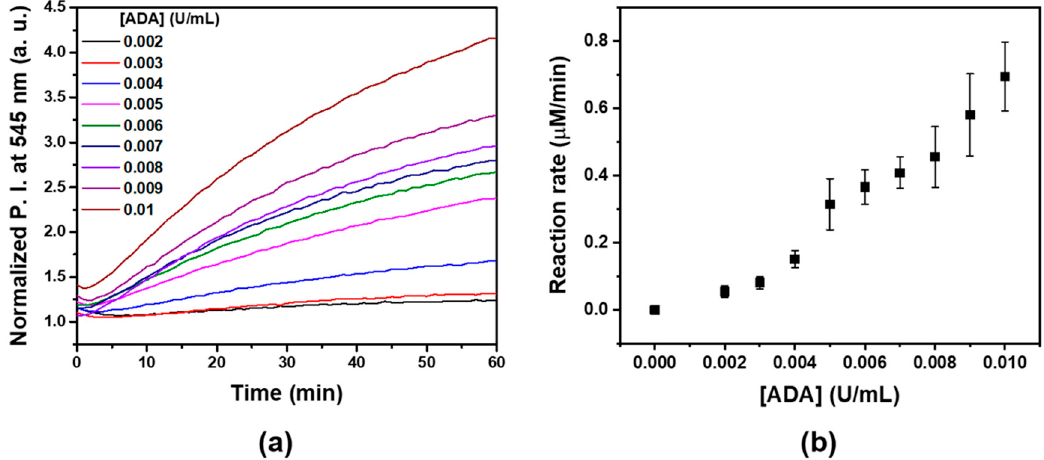
Figure 4. ( a ) Change in the luminescence intensities of a sample containing adenosine (50 μ M) and Tb 3+ (1 mM) with various concentrations of ADA in buffer condition (pH 8; HEPES, 20 mM). ( b ) Plot of the reaction rate of ADA versus various concentrations of ADA in a combination of adenosine (50 μ M) and Tb 3+ (1 mM) in buffer condition (pH 8; HEPES, 20 mM). λ ex = 260 nm.